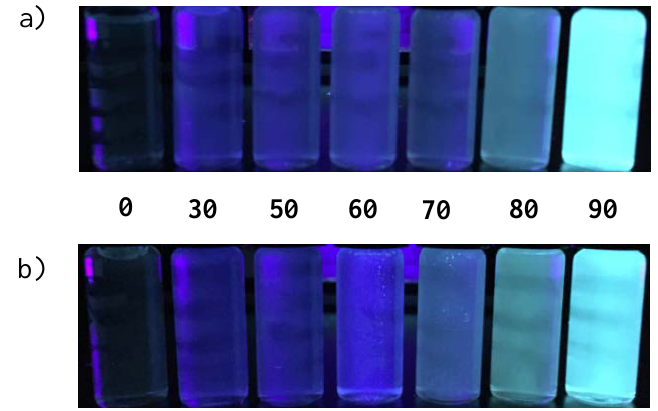
Figure 3. Photographs of ( a ) mTPEP and ( b ) pTPEP in THF/water mixture with different fraction of water taken under UV light (365 nm).